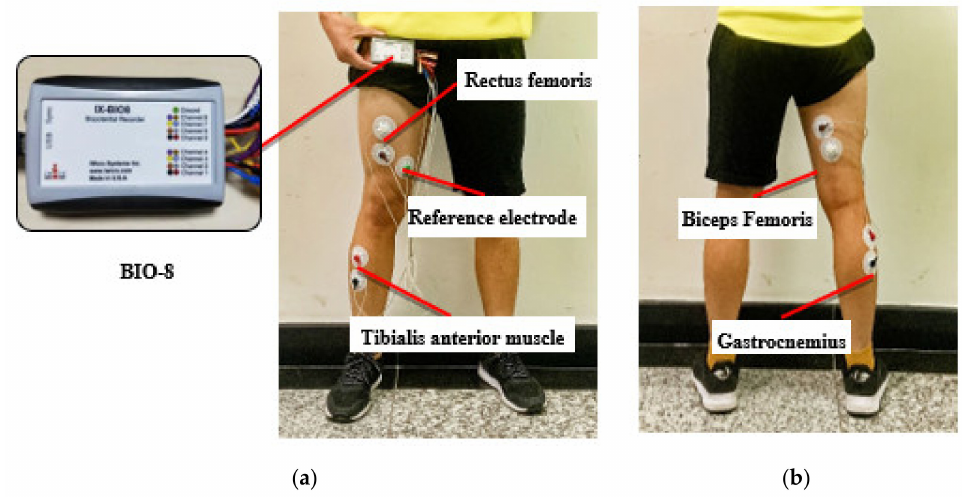
Figure 3. Position of selected muscles and reference electrodes: ( a ) front side; ( b ) back